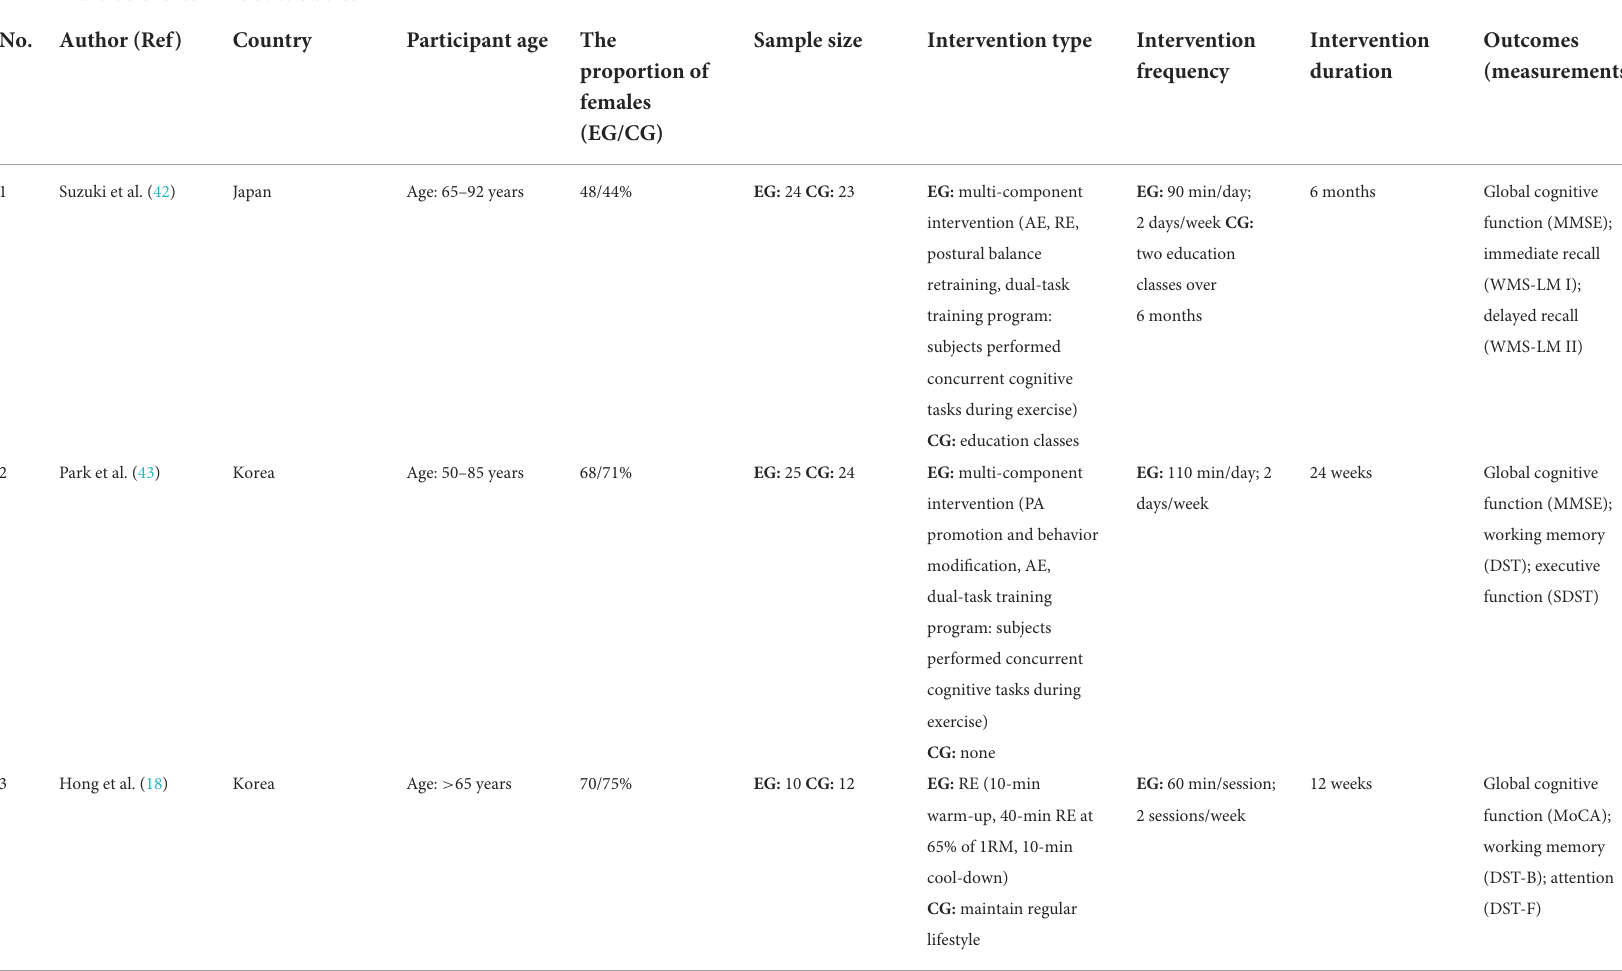
TABLE 2 Characteristics of included